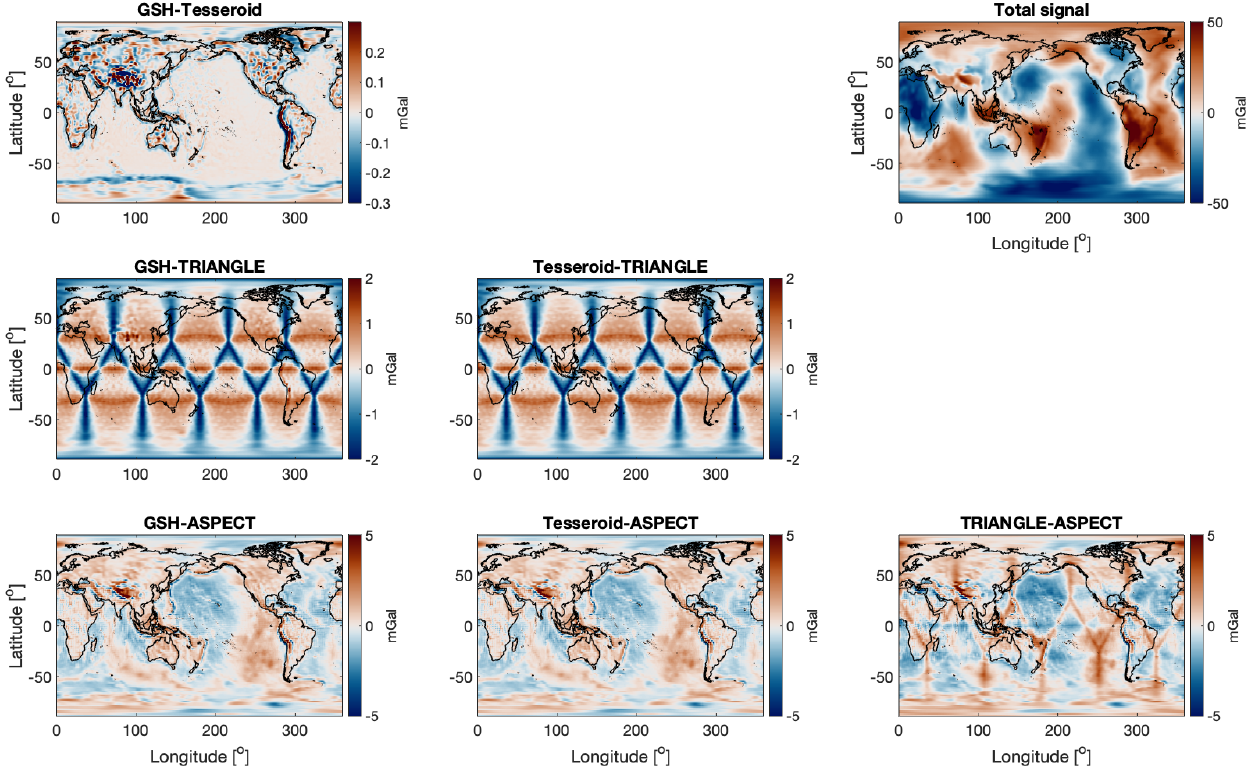
Figure 9. Gravity radial component at 250km height comparison of the forward-modelled WINTERC-G model by the different forward modelling approaches. Spherical harmonic coefficients 2–179 ◦ and order are